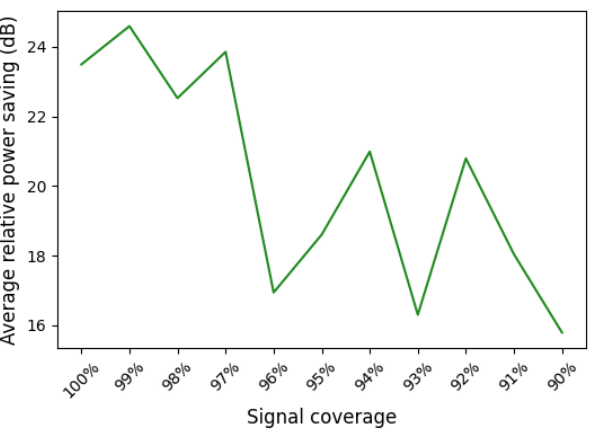
Figure 12. Significance of considering radiation pattern for AP placement optimization. The average relative power saving when generating AP placements considering the radiation pattern compared with the situation where we do not consider the radiation pattern, using patch